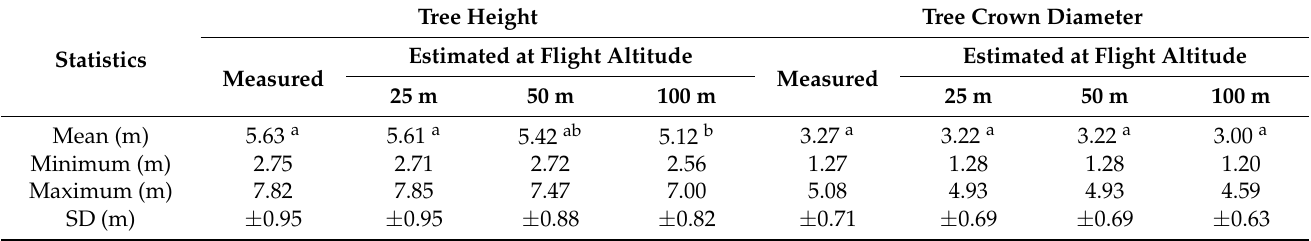
Table 3. Statistics of the indirect measured and estimated variables at different flight altitudes, and the results of Tukey’s test.